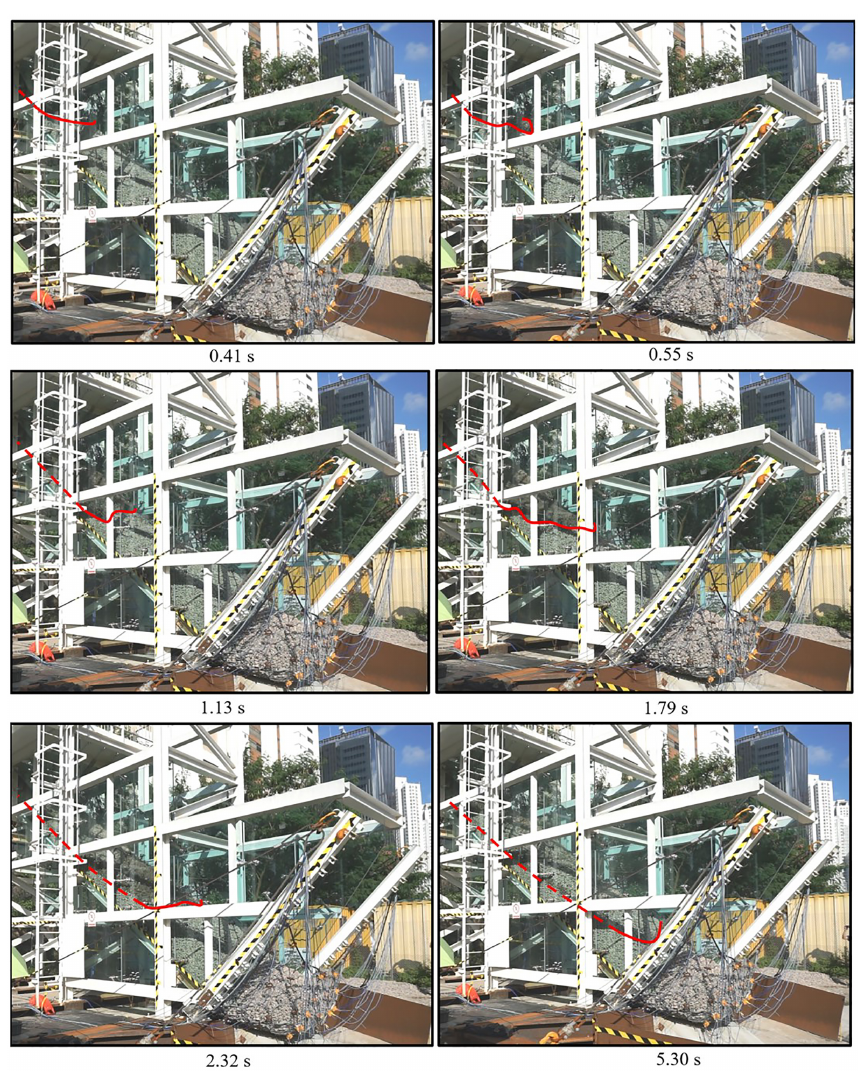
Figure 9. Motion of the granular flow in test